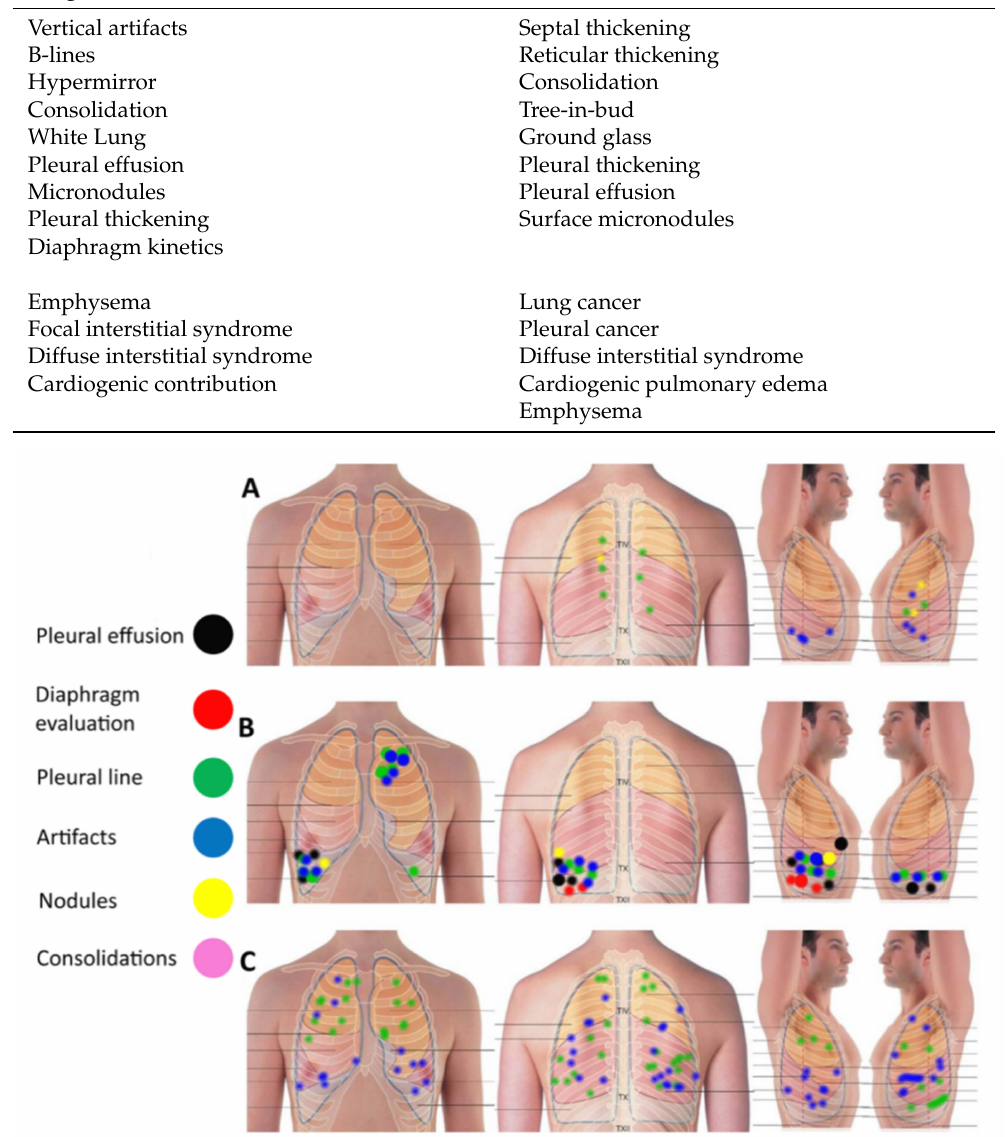
Figure 1. Example of the location of ultrasound (US) findings on the thoracic surface through a graphic scheme with differently colored landmarks, to obtain a superficial topography comparable to CT images. Three schemes of three different patients are shown in A, B and